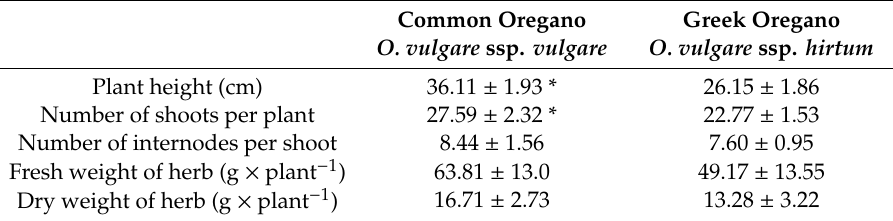
Table 3. Morphological traits of investigated plants